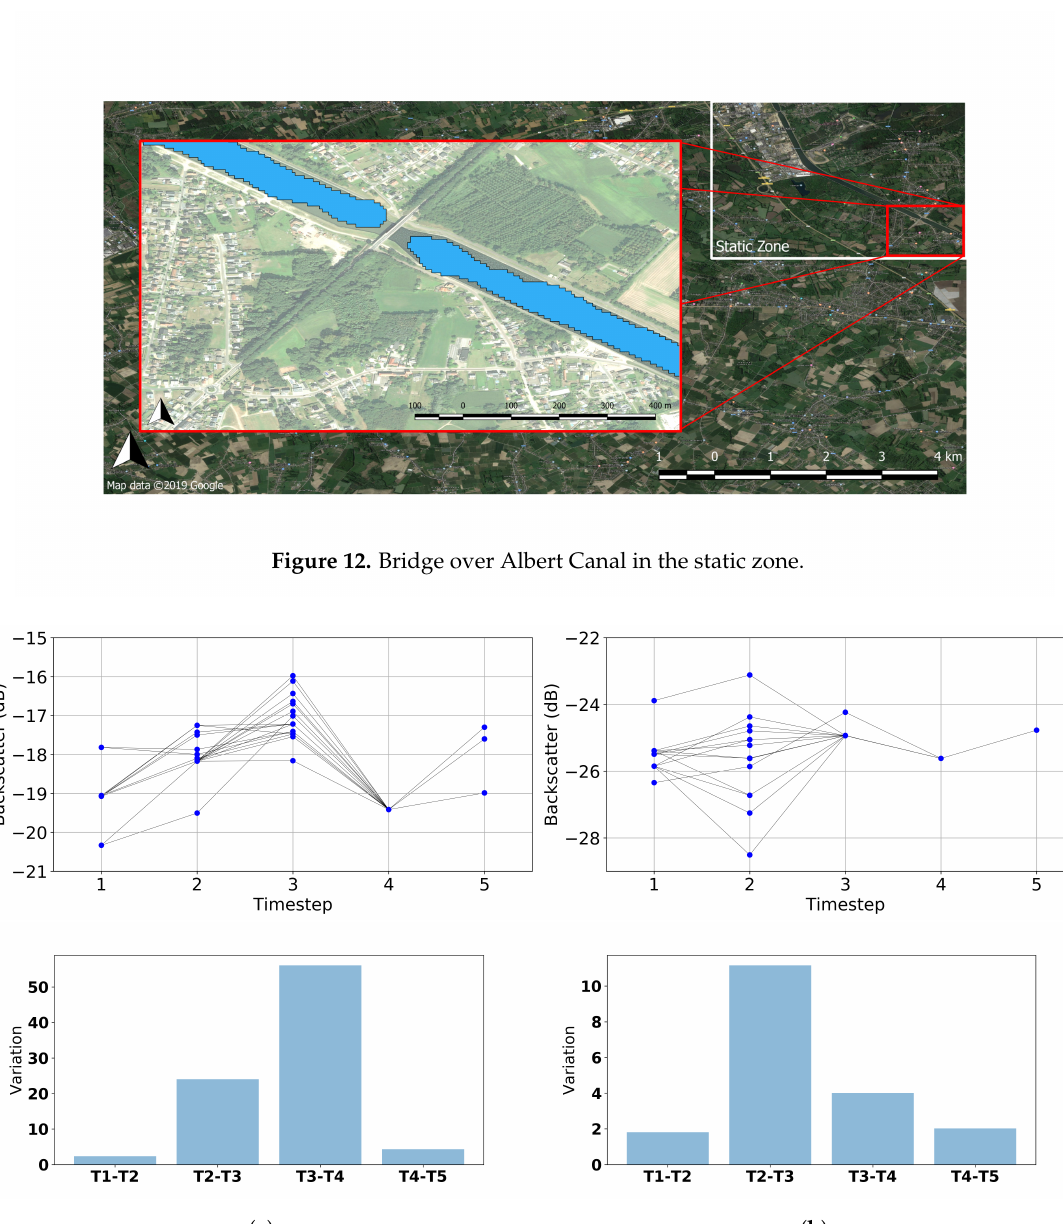
Figure 13. Temporal profile and variation VV versus VH polarisation for ascending SITS in the static zone. ( a ) Ascending VV. ( b ) Ascending